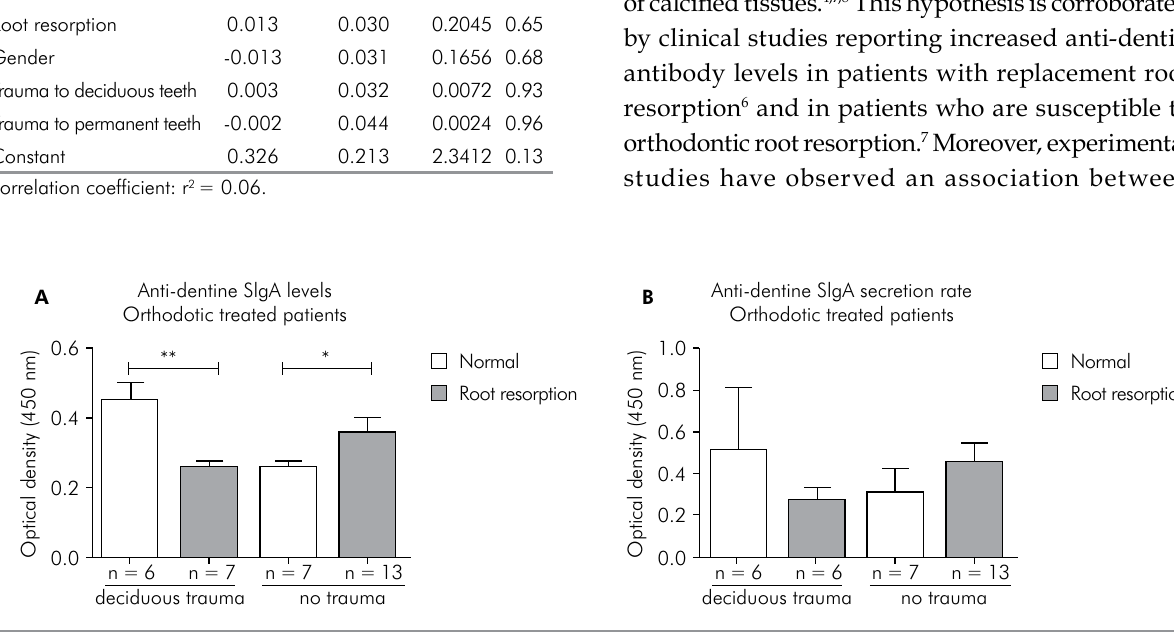
Figure 3. (a) Anti-dentin SIgA levels and (b) secretion rates in orthodontically treated patients with or without trauma of deciduous teeth. The white column represents patients with no radiographic signs of root resorption in permanent upper incisors. Black columns represent patients presenting root resorption in permanent upper incisors. Root resorption: **p < 0.01; *p < 0.05, Student’s t-test.